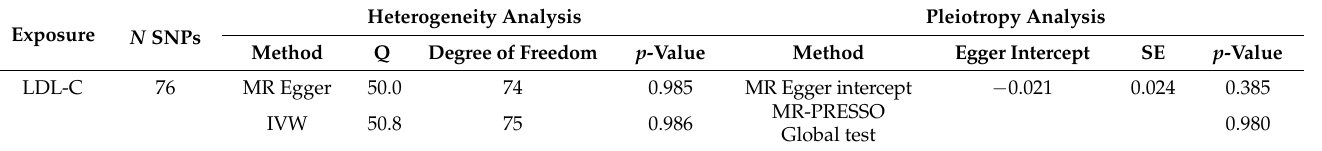
Table 1. Heterogeneity and pleiotropy tests of instrument effects.